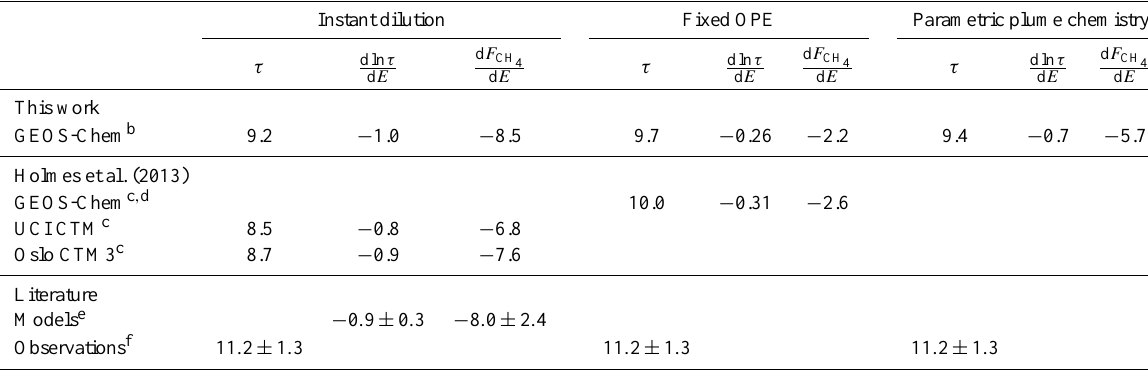
Table 3. Effect of ship NO x emissions on CH 4 lifetime and RF a .